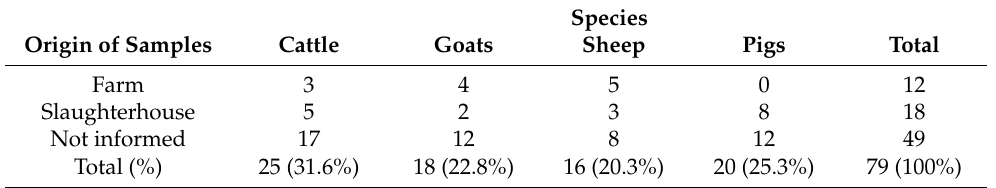
Table 2. Origin of the cases of neoplasms included in the studies according to the species infected.